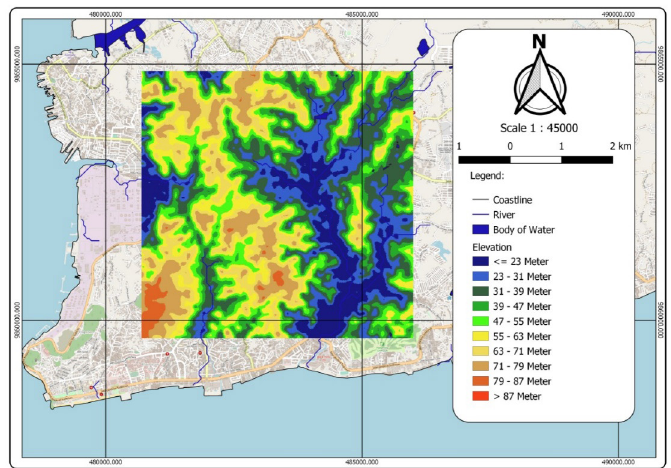
Figure 3. Study site: Balikpapan city, East Borneo